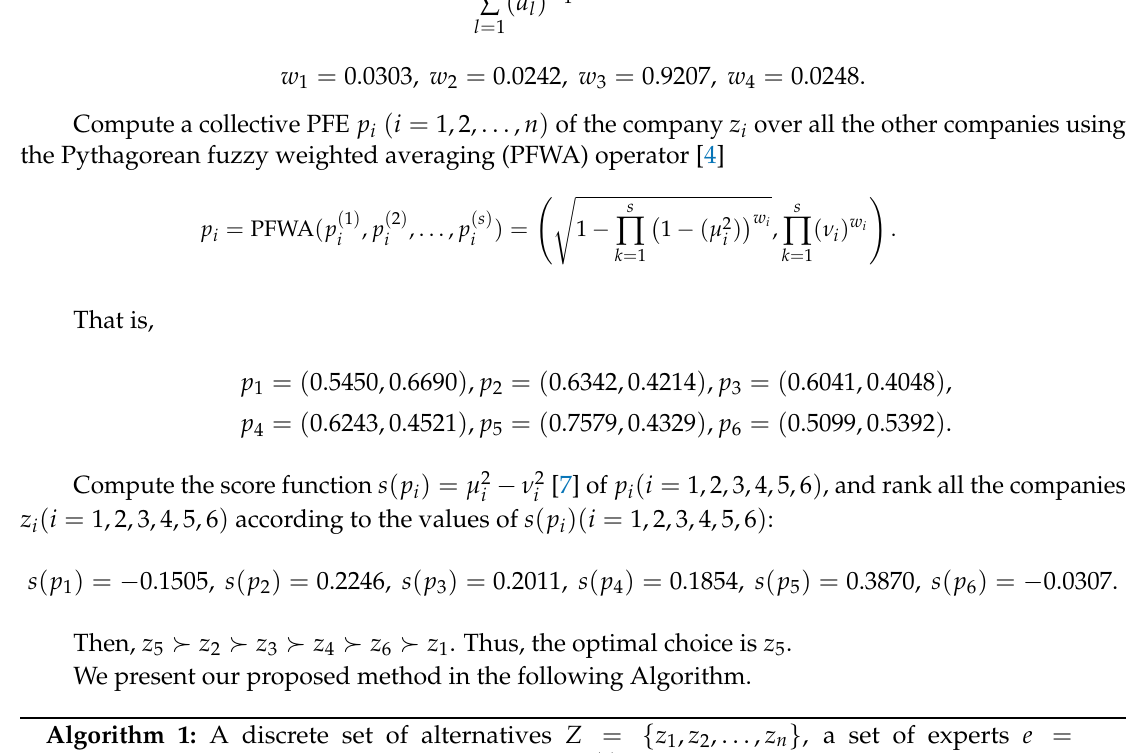
Algorithm 1: A discrete set of alternatives Z =